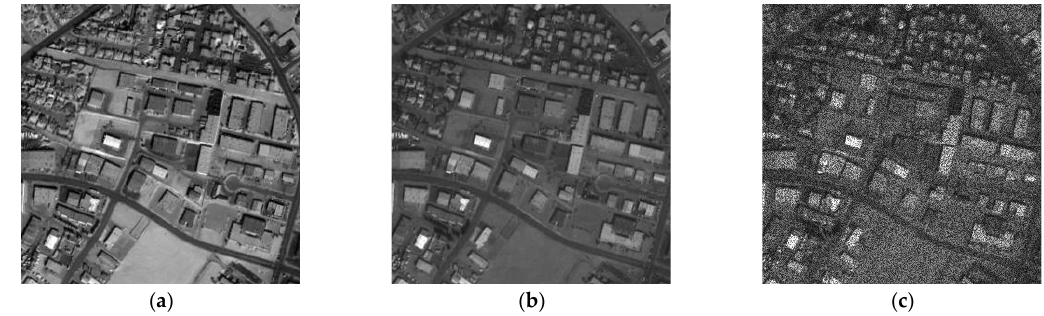
Figure 7. Synthetic image pair from Quickbird: ( a ) R-band; ( b ) B-band; ( c ) Synthetic SAR image. Six image pairs were obtained to perform the contrast experiment. Optical images